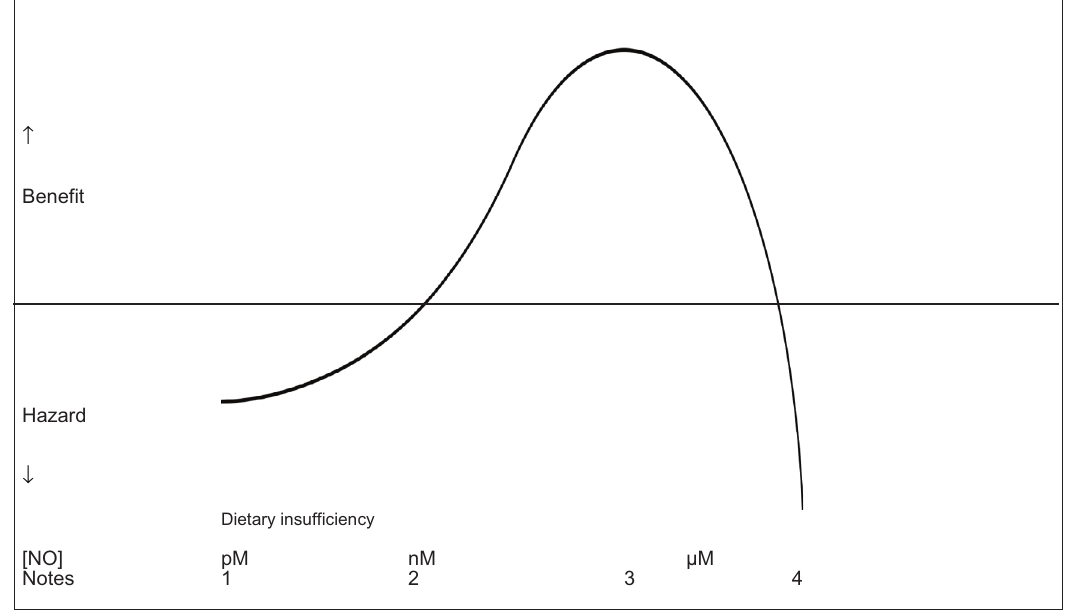
Figure 1. Schematic of concentration response curve for antimicrobial effects of nitric oxide. 1. Reduced eNOS-derived NO related to dietary insufficiency, older age, vascular disease 2. Normal eNOS-derived vascular NO 3. iNOS-derived NO or low/moderate dose exogenous NO source 4. iNOS-derived NO in septic shock or high dose exogenous NO